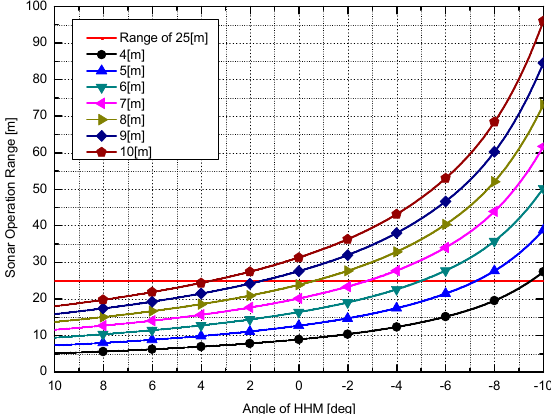
Figure 23. Correlation between the angle of HHM and sonar operation range.